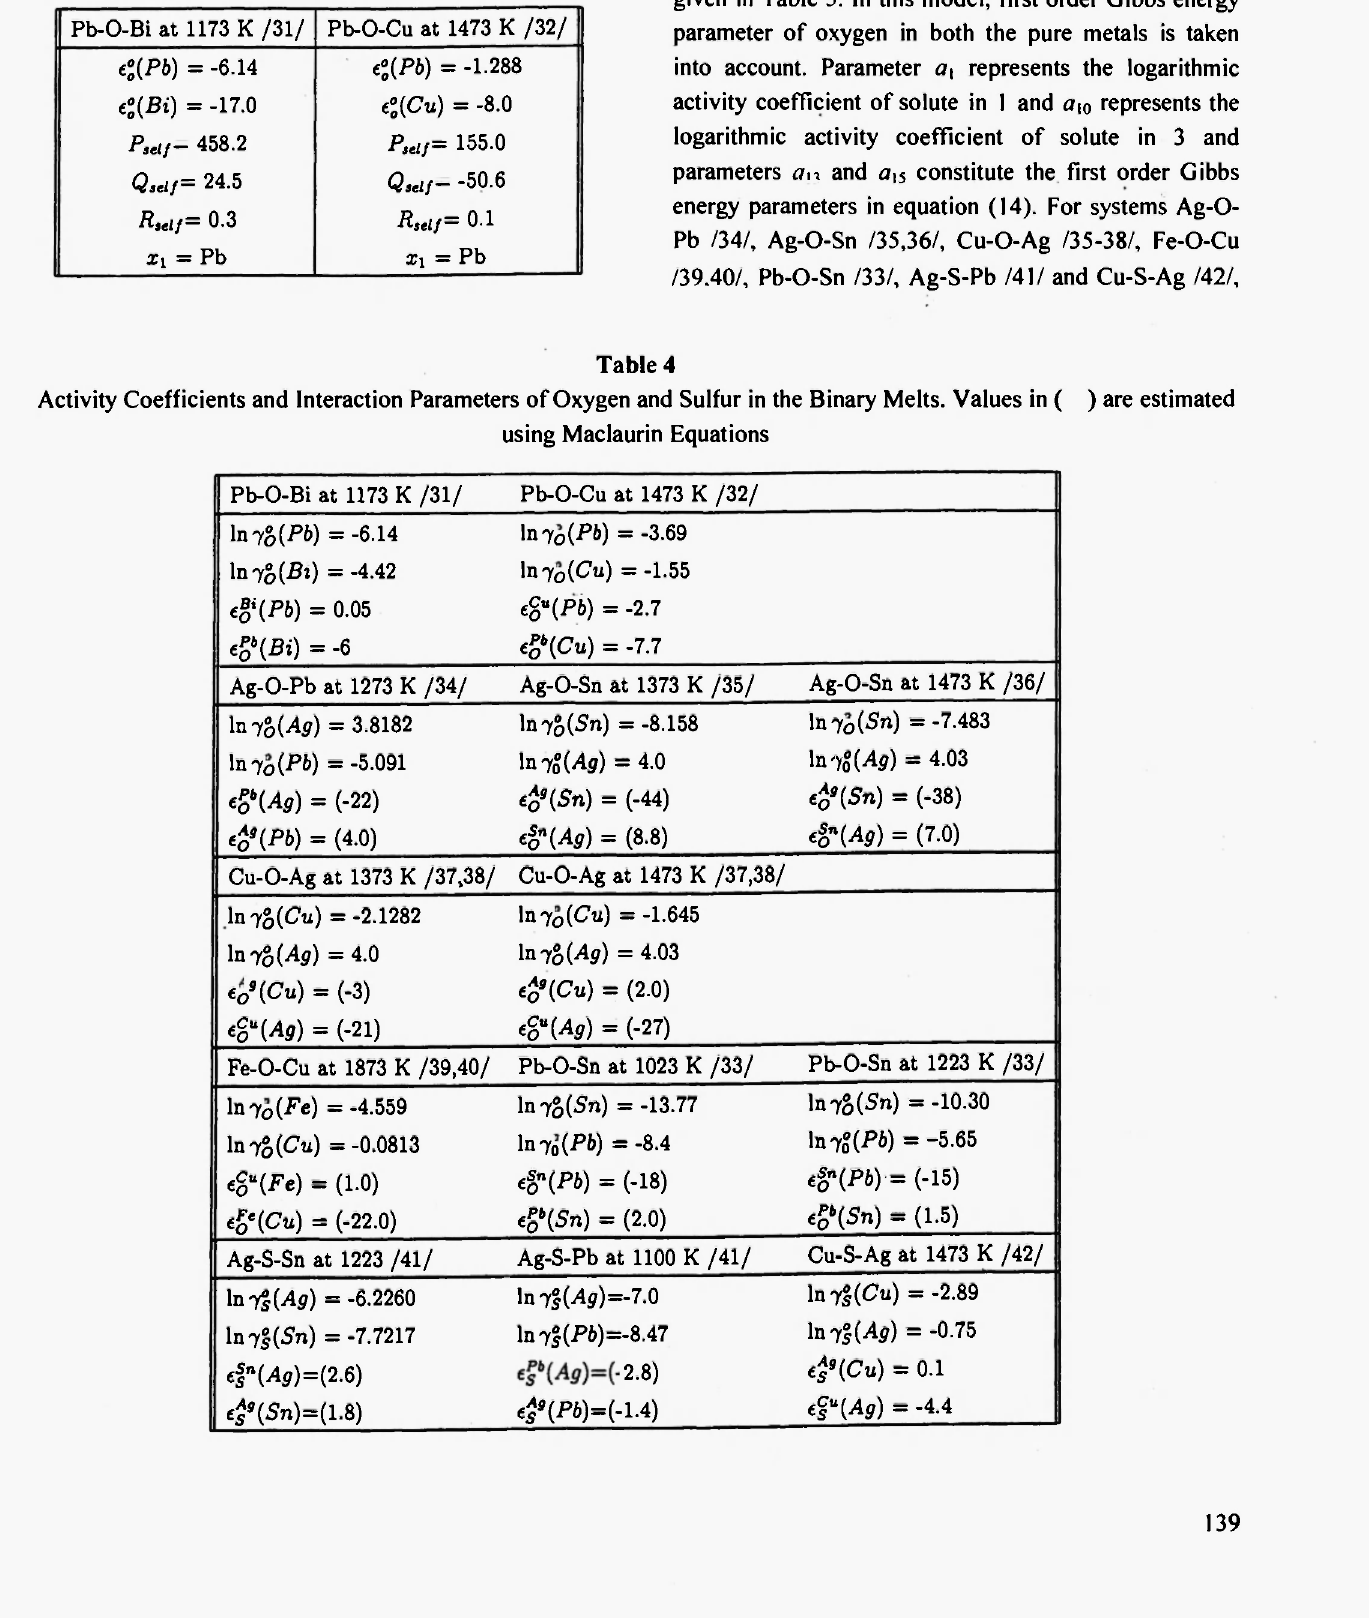
Self-Interaction and Margules Coefficients of Oxygen in